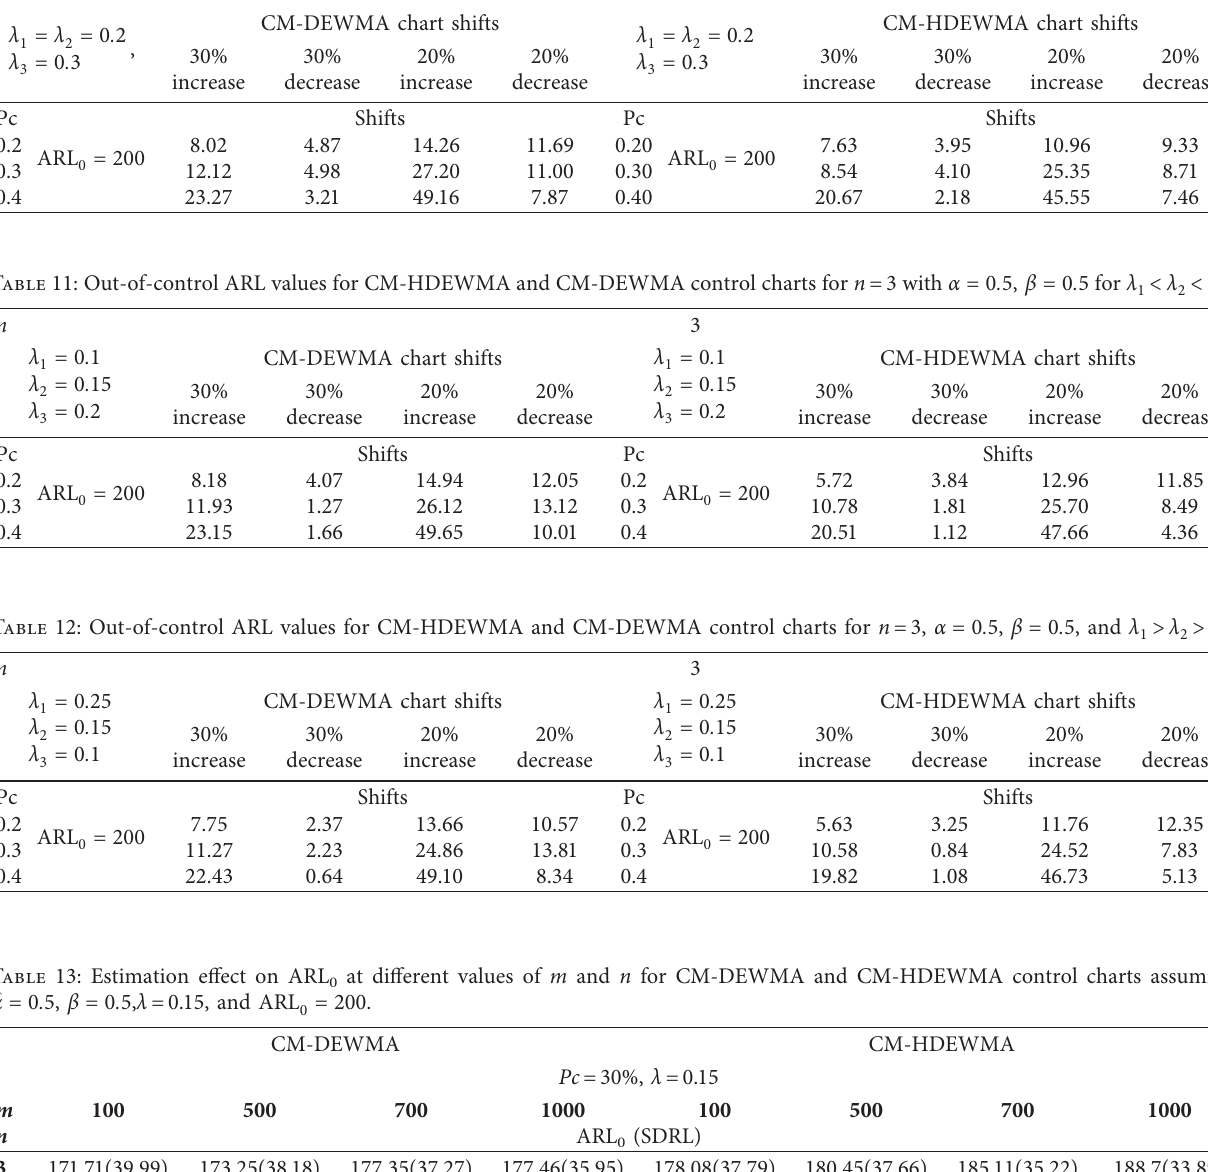
Table 10: Out-of-control ARL values for CM-HDEWMA and CM-DEWMA control charts for n � 7 with MLE α ⌢ � 1 . 43 , β � 2. n 7 � λ � 0 . 2 λ 1 2